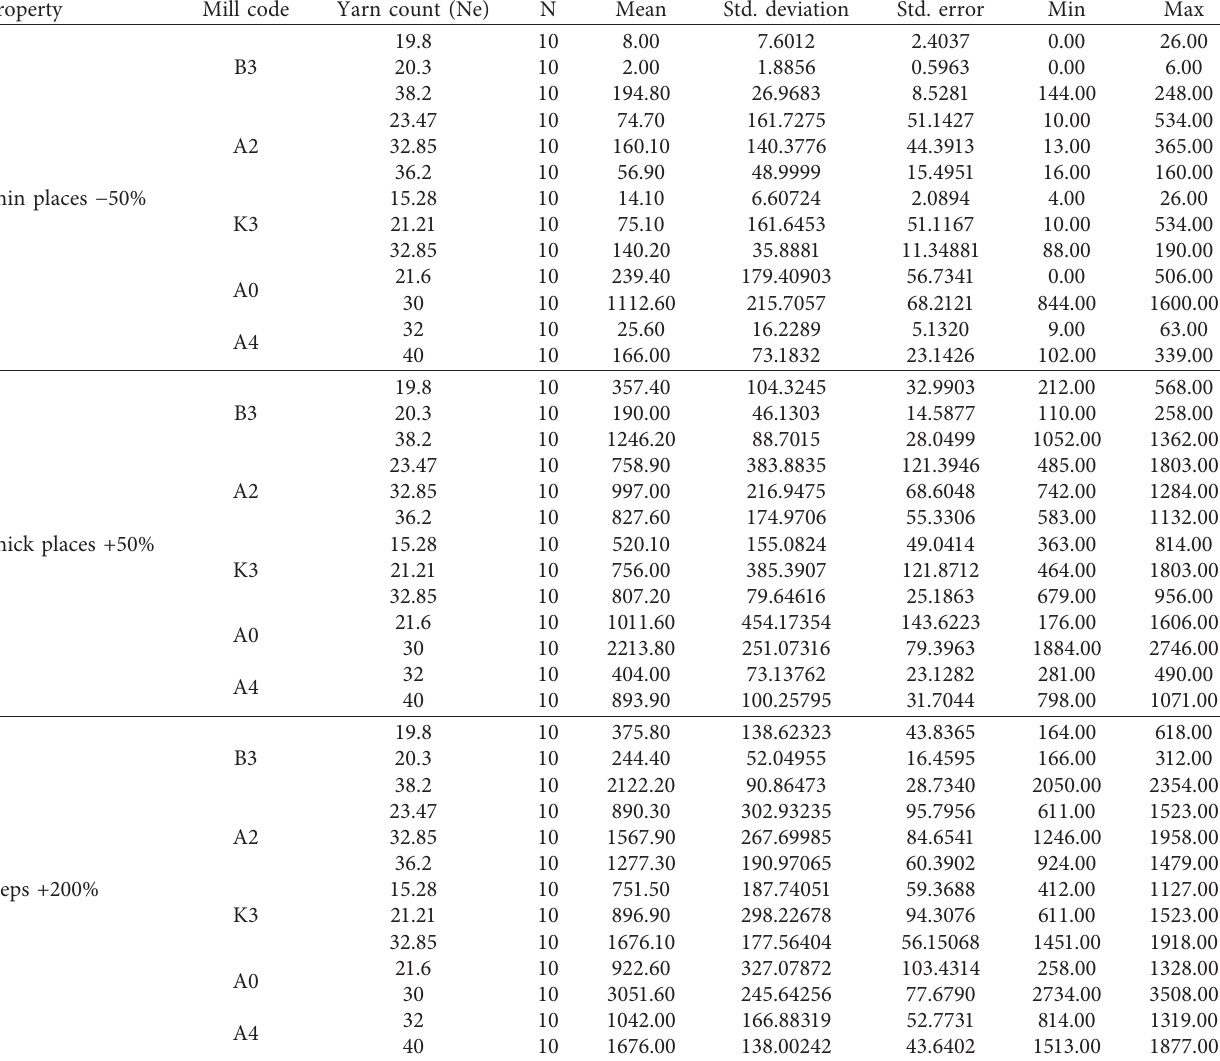
Table 4: Descriptive analysis of yarn imperfections.